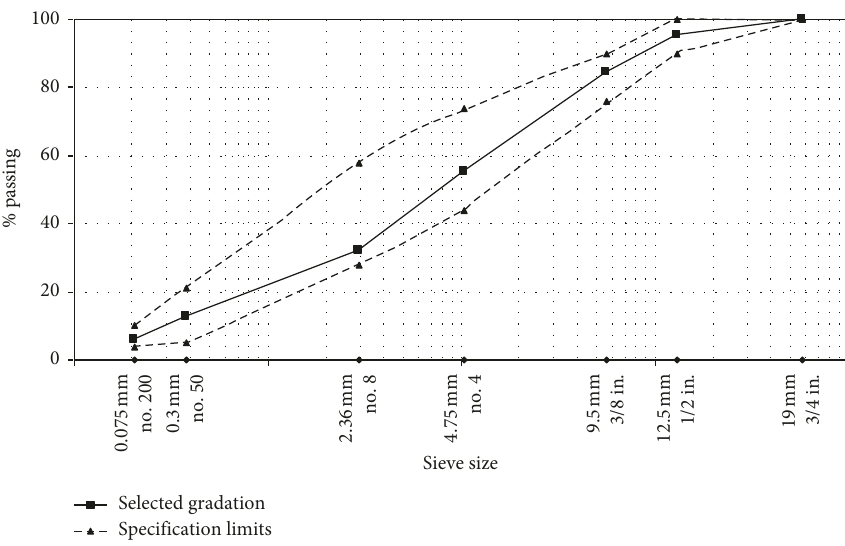
Figure 3: Selected aggregate gradation and specification limit. Table 3: Properties of fillers.